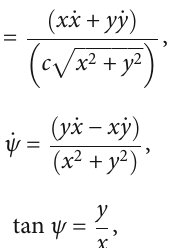
ω ω − ω ω + ω 1 ; (b) 2 ; (c) 1 2 ; (d) 1 2